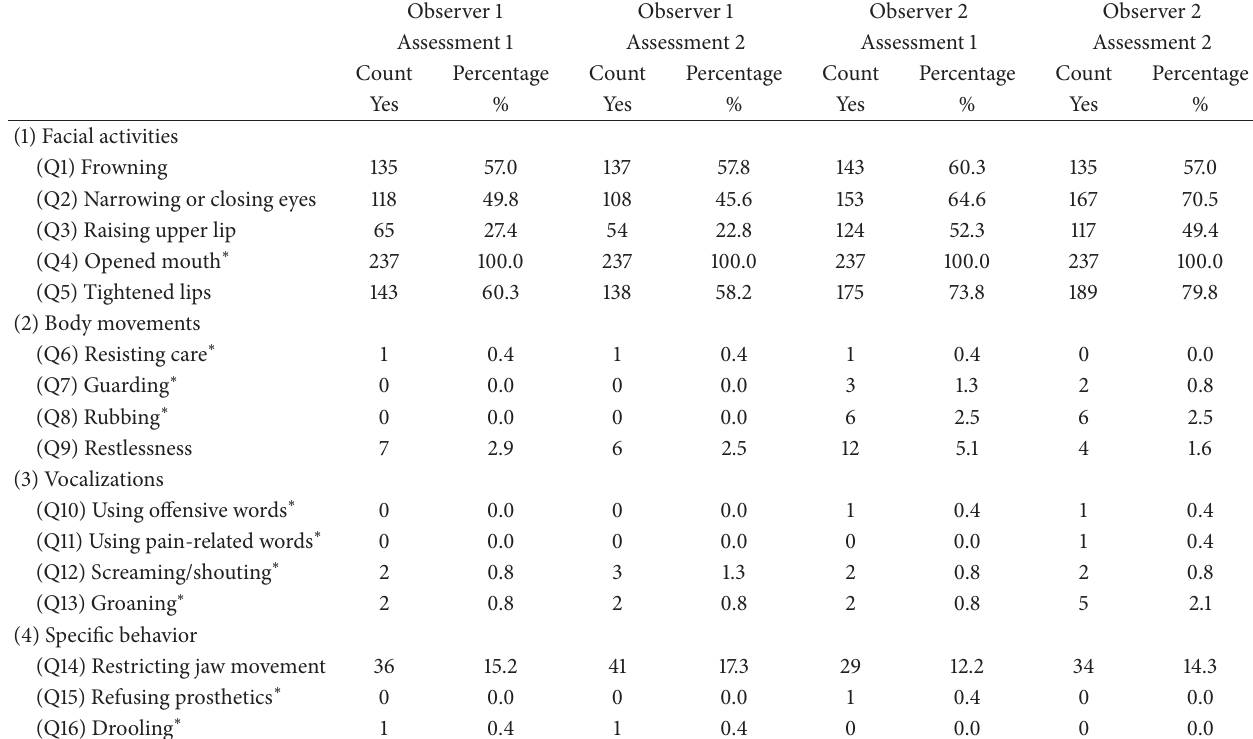
Table 2: Proportion of positive observations of the OPS-NVI items by observer and assessment ( 𝑁 = 237 video